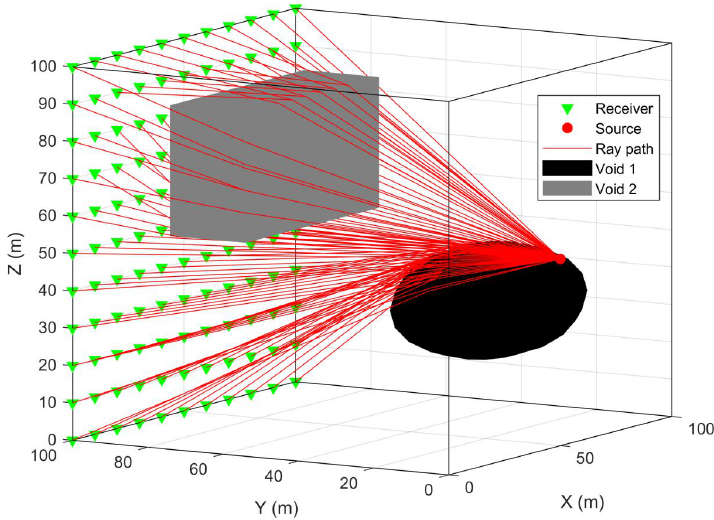
Figure 9. In the case of two voids, the ray path is calculated by the proposed